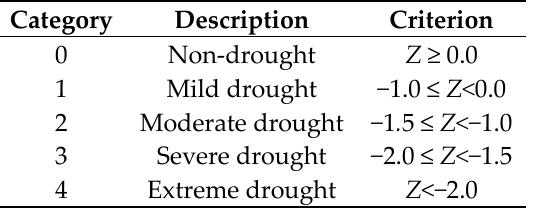
Table 1. Classification of hydrological drought based on the random variable Z.